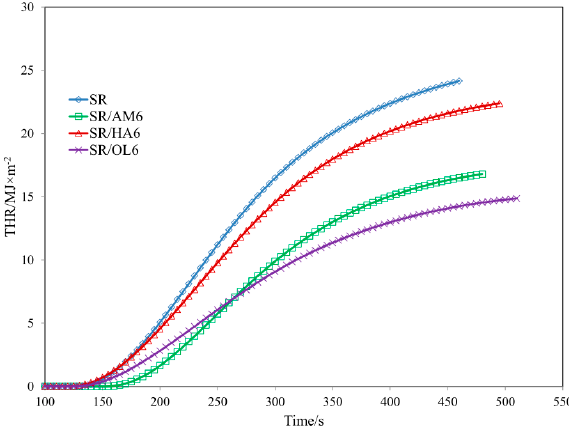
Figure 10. THR curves of SR/POSS composites.